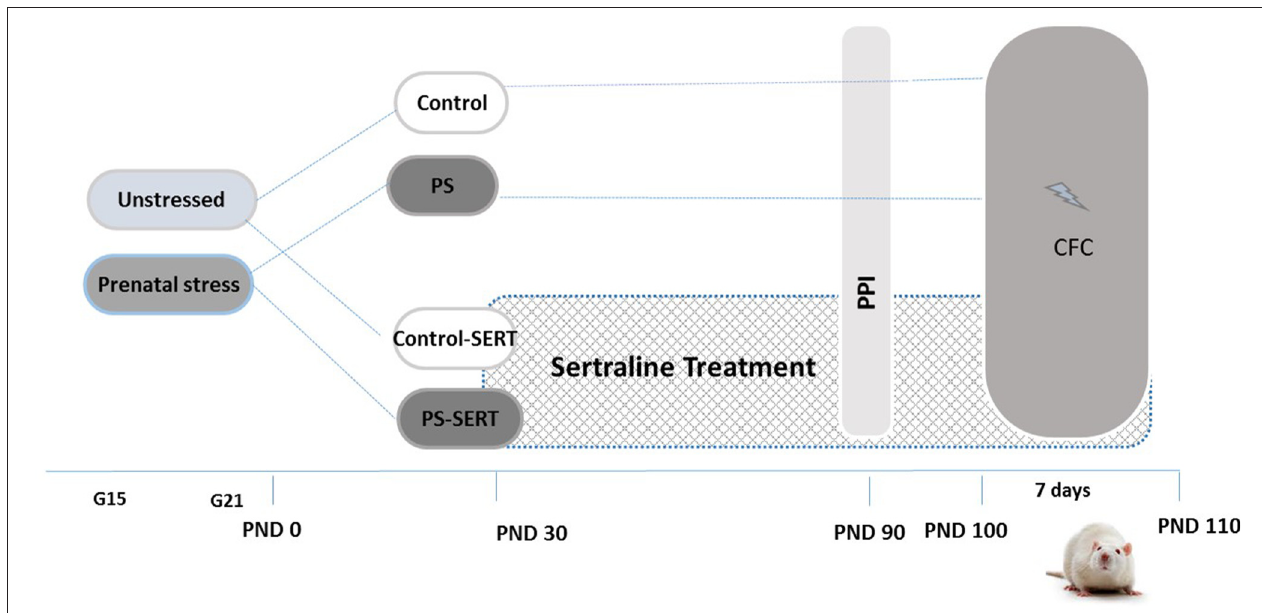
FIGURE 1 | Experimental design and timeline. Non-stressed or prenatally stressed offspring of both sexes, treated with Sertraline (SERT) (Control-SERT and PS-SERT; 5 mg/kg/day), or not (PS and Control; n = 14 animals on each group and sex, respectively), were exposed to the prepulse inhibition (PPI) test at postnatal day 90 (PND 90), and to the Contextual fear conditioning paradigm (CFC; starting at PND 100). Abbreviations: G15 and G21, gestational days 15 and 21.